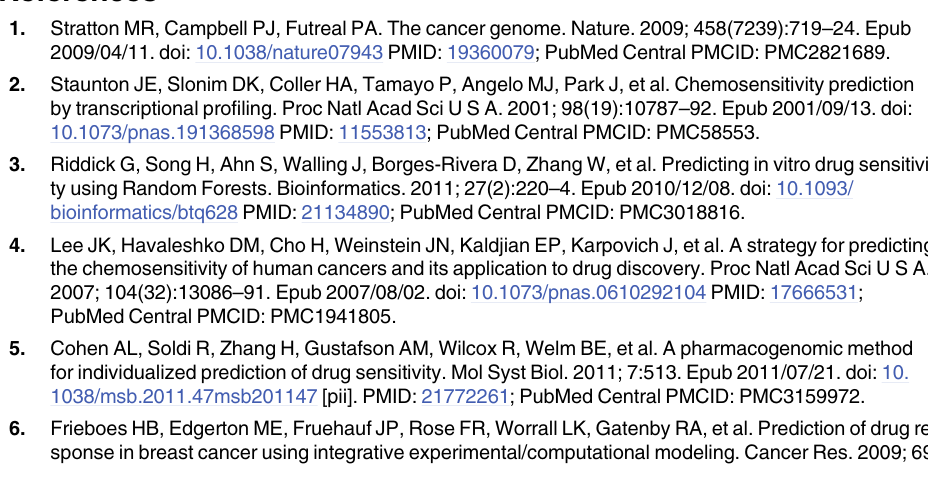
S1 Table. Mutation, copy number and drug response data in CGP